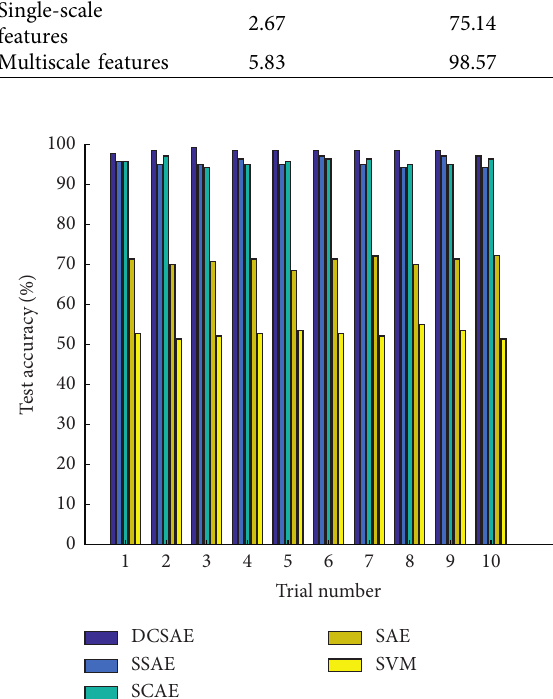
Figure 7: Diagnosis results of the 10 trials using the five methods.